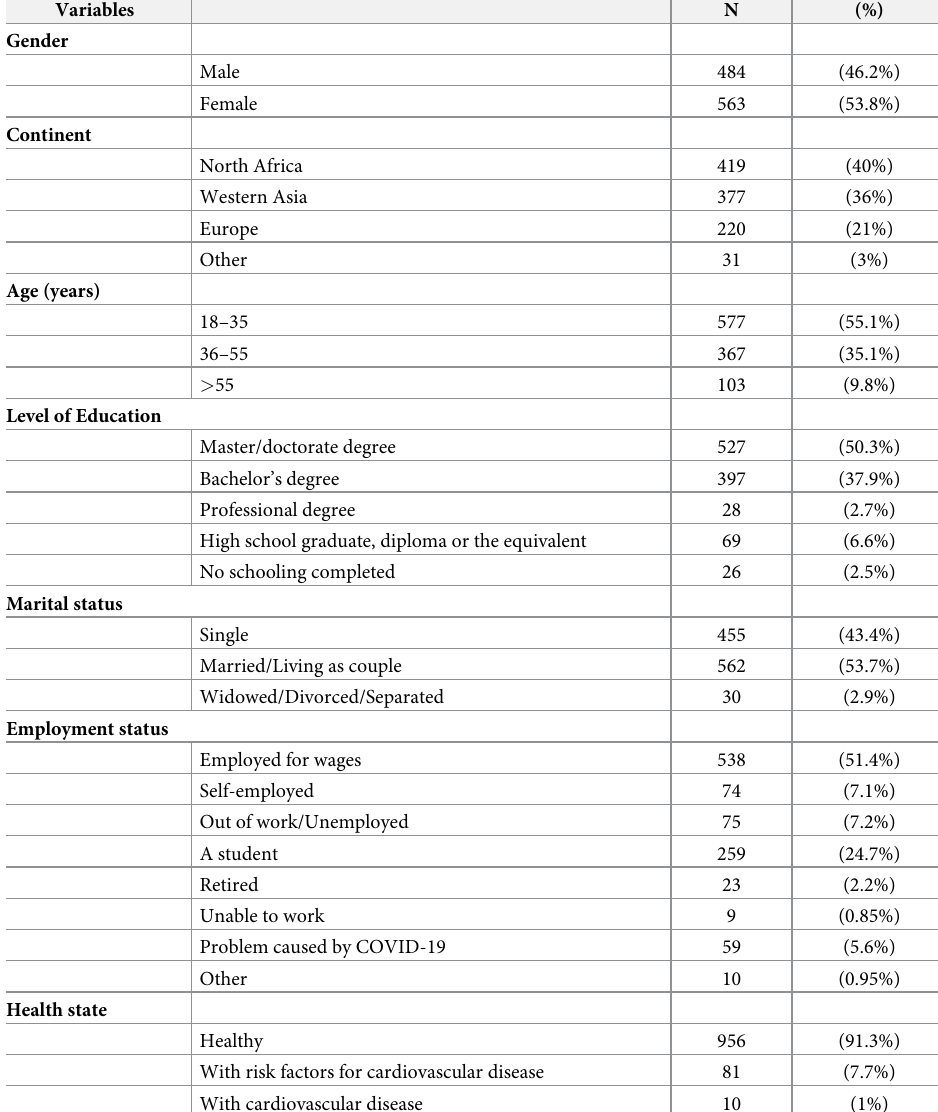
Table 1. Demographic characteristics of the